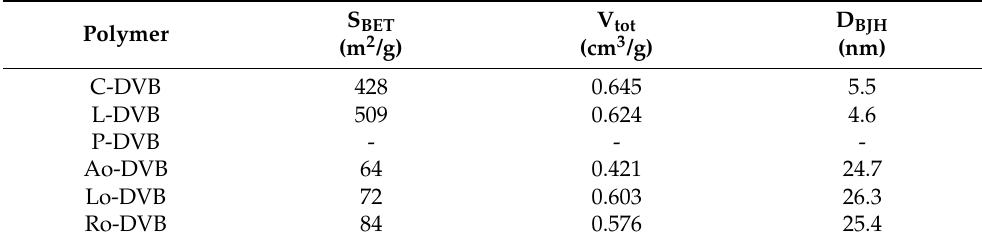
Table 4. Porous structure parameters of the prepared polymeric materials.